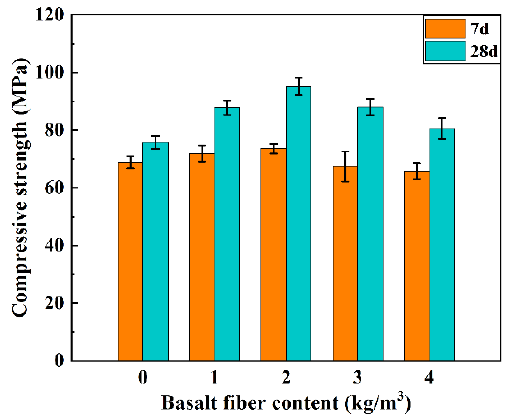
Figure 8. Compressive strength.